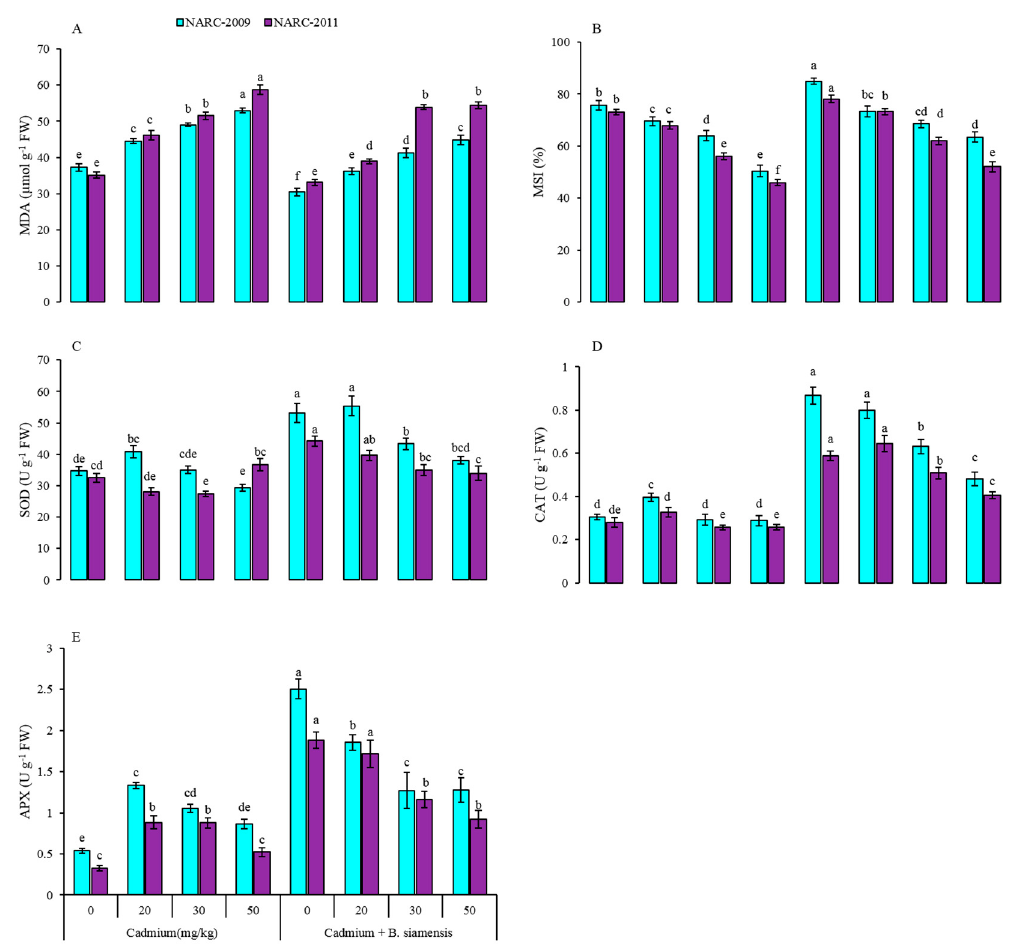
Figure 4. Effect of seed inoculation with Bacillus siamensis on malondialdehyde (MDA) ( A ), membrane stability index (MSI) ( B ), superoxide dismutase (SOD) ( C ), catalase (CAT) ( D ), and ascorbate peroxidase (APX) ( E ) of two wheat varieties under Cd stress. Data are expressed as the means of three replicates. Bars show ± SD and different letters show a significant difference among treatments at 0.05 level.